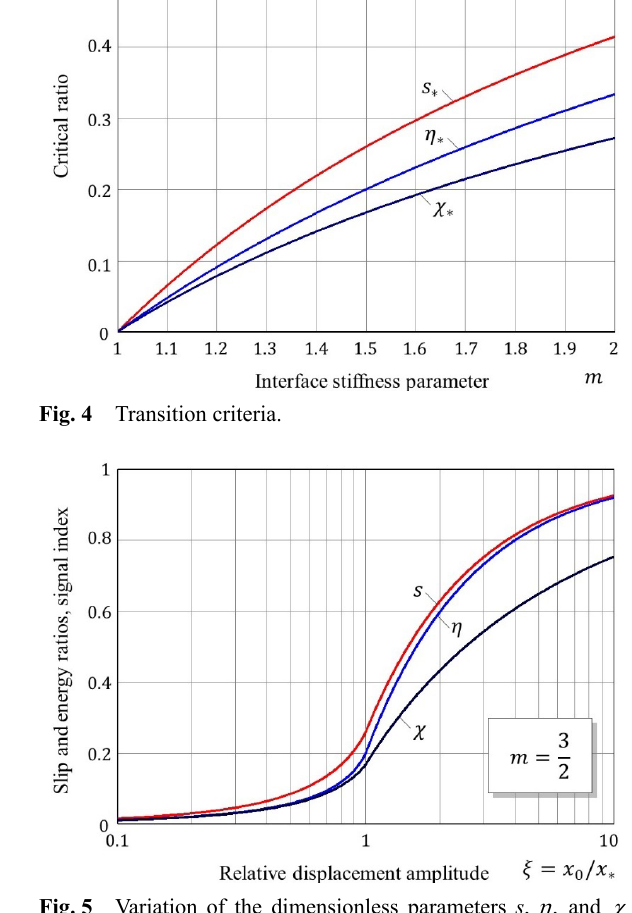
Fig. 5 Variation of the dimensionless parameters s , ,  and  as functions of .